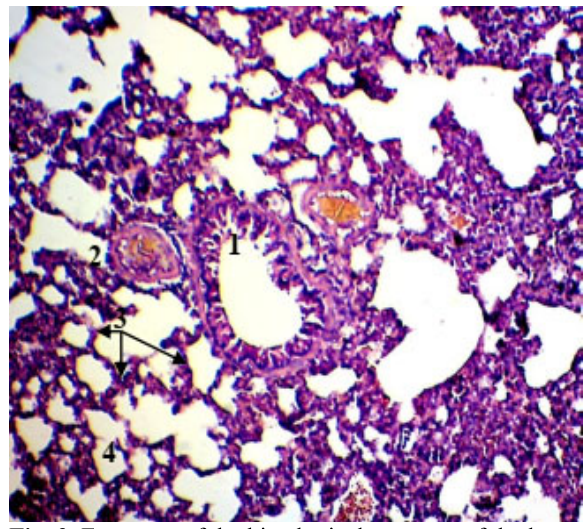
Fig. 3. Fragment of the histological structure of the lungs Fig. 4. Fragment of the histological structure of the lungs of a mature rabbit: 1 – small bronchus; 2 – vessels; of a mature rabbit: 1 – large bronchus; 2 – multi-row 3 – alveolar septum; 4 – alveoli. Hematoxylin and eosin. ciliated epithelium; 3 – cartilaginous islands; Hematoxylin X. 120. and eosin. X